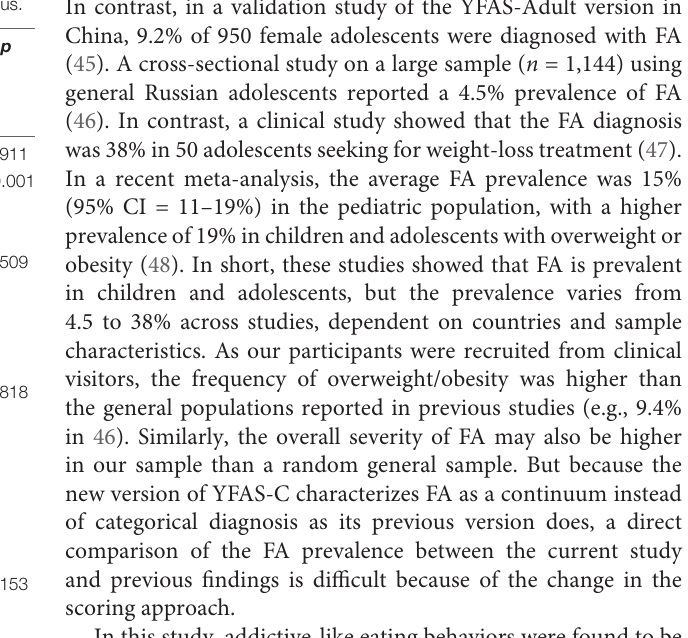
TABLE 1 | The characters of participants and the association with weight